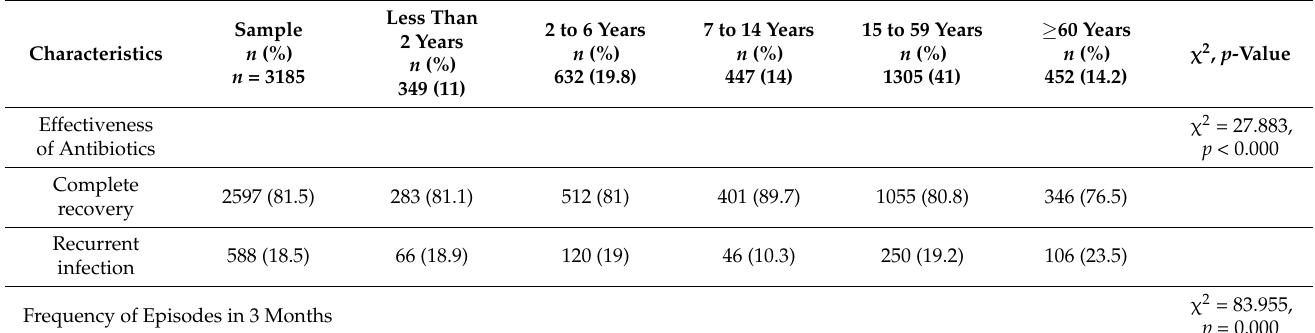
Table 2. Outcome of treatment for respiratory tract